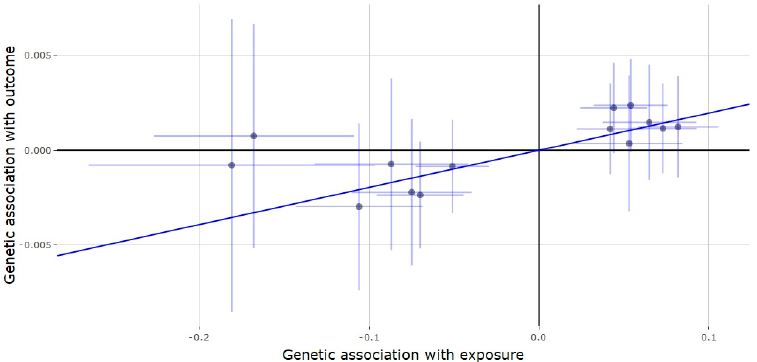
Figure 4. Genetic association of depression against genetic association of testosterone ( SHBG locus). The slope (dark blue line) represents the causal association of testosterone with depression (generated via inverse variance weighted Mendelian randomization), while the points on the plot and the lights around them (light blue lines) represent the SNP and its confidence intervals.